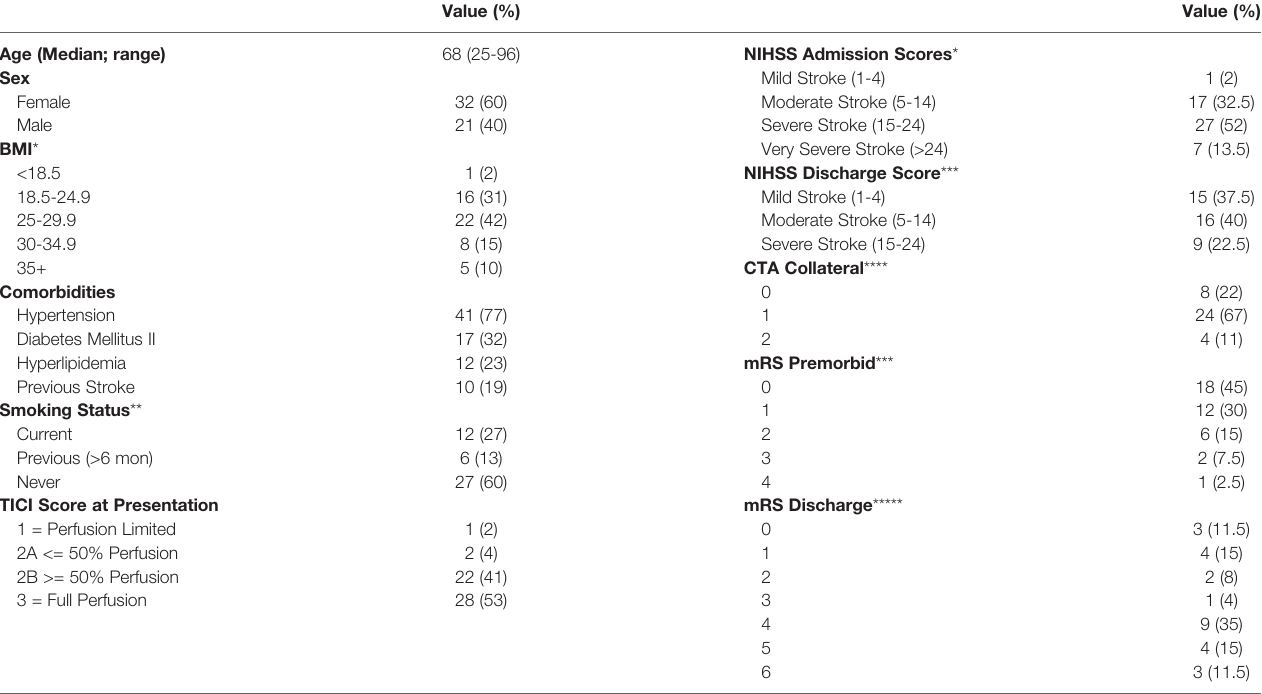
Values are median with range, mean ± SD, or (%). N=53